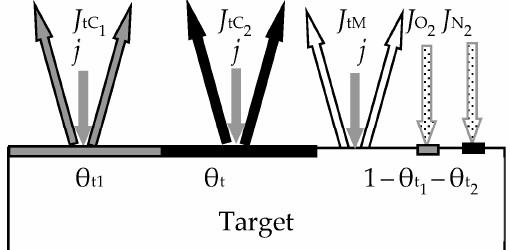
Figure 18. Fluxes on the target.